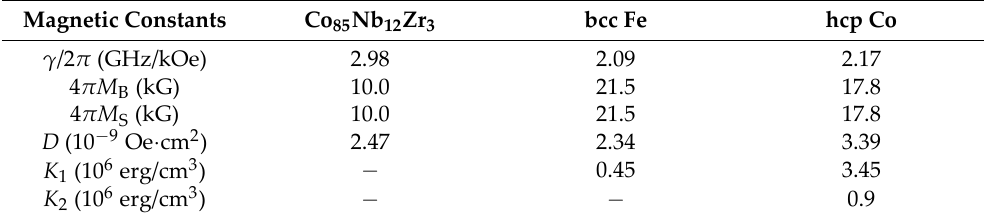
Table 1. Magnetic constants of Co 85 Nb 12 Zr 3, bcc Fe, and hcp Co films used for the SW frequency calculations.